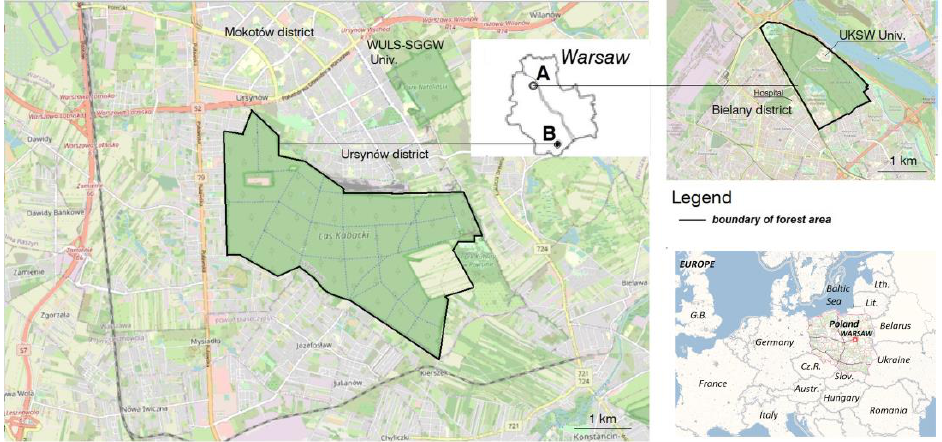
Figure 1. Location of forest areas in Warsaw, Poland: A —the Bielański Forest, B — the Kabacki Forest (author’s elaboration based on: Open Street Maps [ 75] and Geoportal [76]).